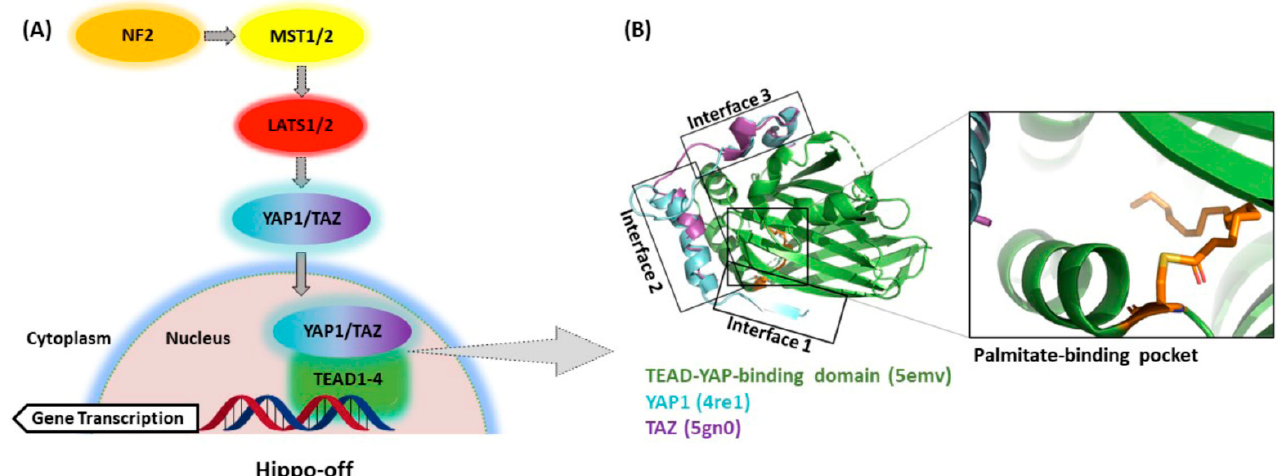
Figure 1. ( A ) In the Hippo-off state, unphosphorylated YAP1/TAZ accumulates in the nucleus and interacts with TEADs to drive the induction of genes involved in proliferation and cell survival. ( B ) Druggability assessment of the YAP1/TAZ– TEAD protein–protein interaction (PPI) has identified several druggable pockets amenable to small- and large-molecule inhibition, including interfaces 2 and 3, as well as the central lipophilic palmitate pocket (PDB: 5emv, 4re1 and 5gn0).